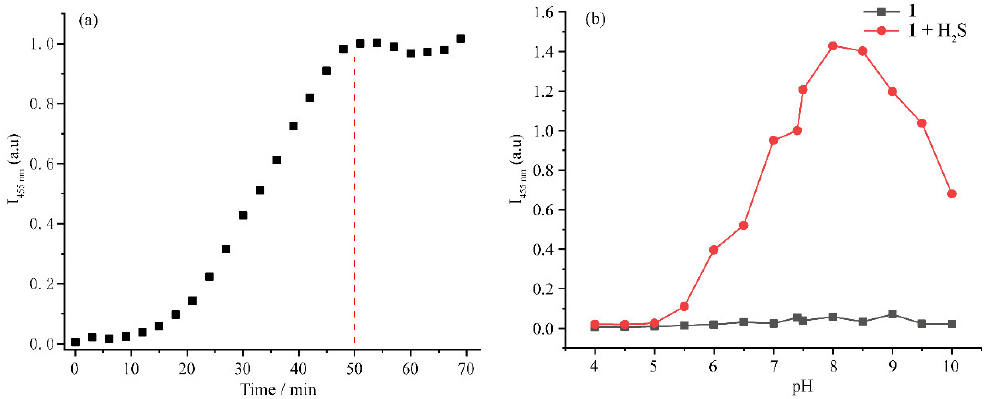
Figure 3. ( a ) Time-dependent fluorescence intensity of 1 at 455 nm in the presence of 10 equiv. of H 2 S in H 2 O-CH 3 CN (1:1, v/v , 10 mM PBS, pH = 7.40) mixed aqueous medium (λ ex = 413 nm, slit = 10 nm/10 nm). ( b ) pH-dependent fluorescence intensity of 1 at 455 nm followed by the addition of 10 equiv. of H 2 S in H 2 O-CH 3 CN (sodium hydroxide and hydrochloric acid were used to modulate the pH values).